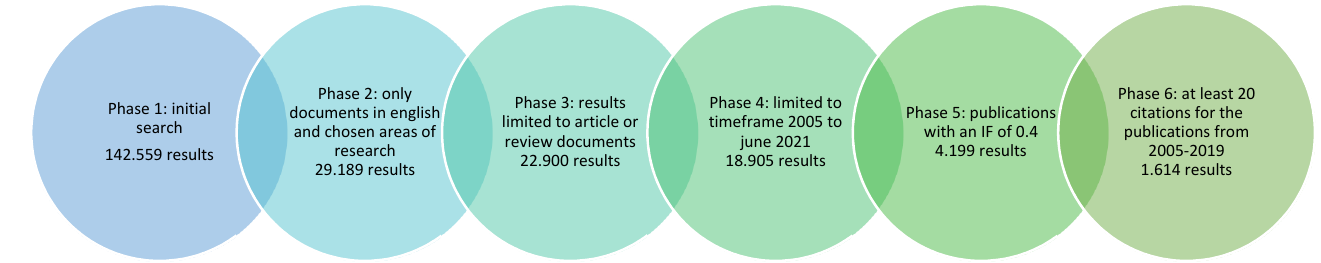
Figure 1. Phases for building the database (Source: own elaboration).